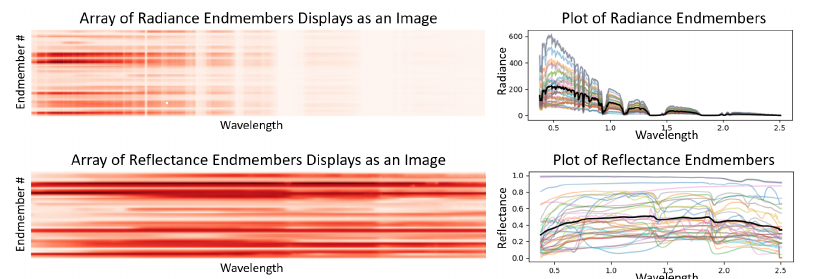
Figure 10. The training data for the auto encoder is an array of the radiance endmembers ( upper-left ) and array of the reflectance endmembers ( lower-left ). The plots for each of these is shown to the